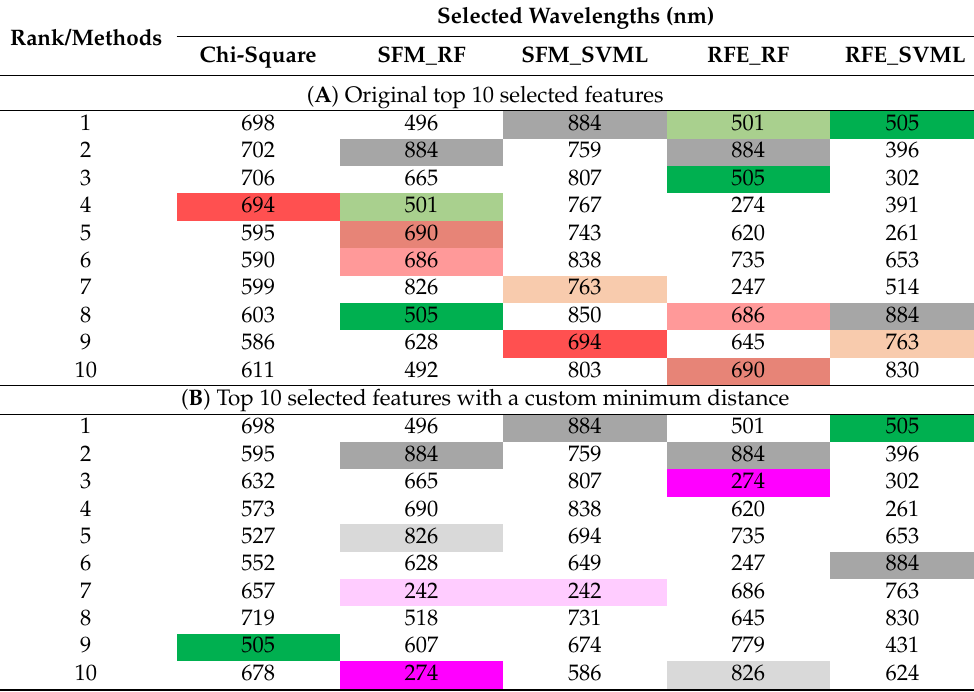
Table 1. The original top 10 features for the classification of peanut stem rot ( A ) and the top 10 features with a custom minimum distance of 20 nm ( B ) selected by different feature selection methods from the scikit-learn machine-learning library in